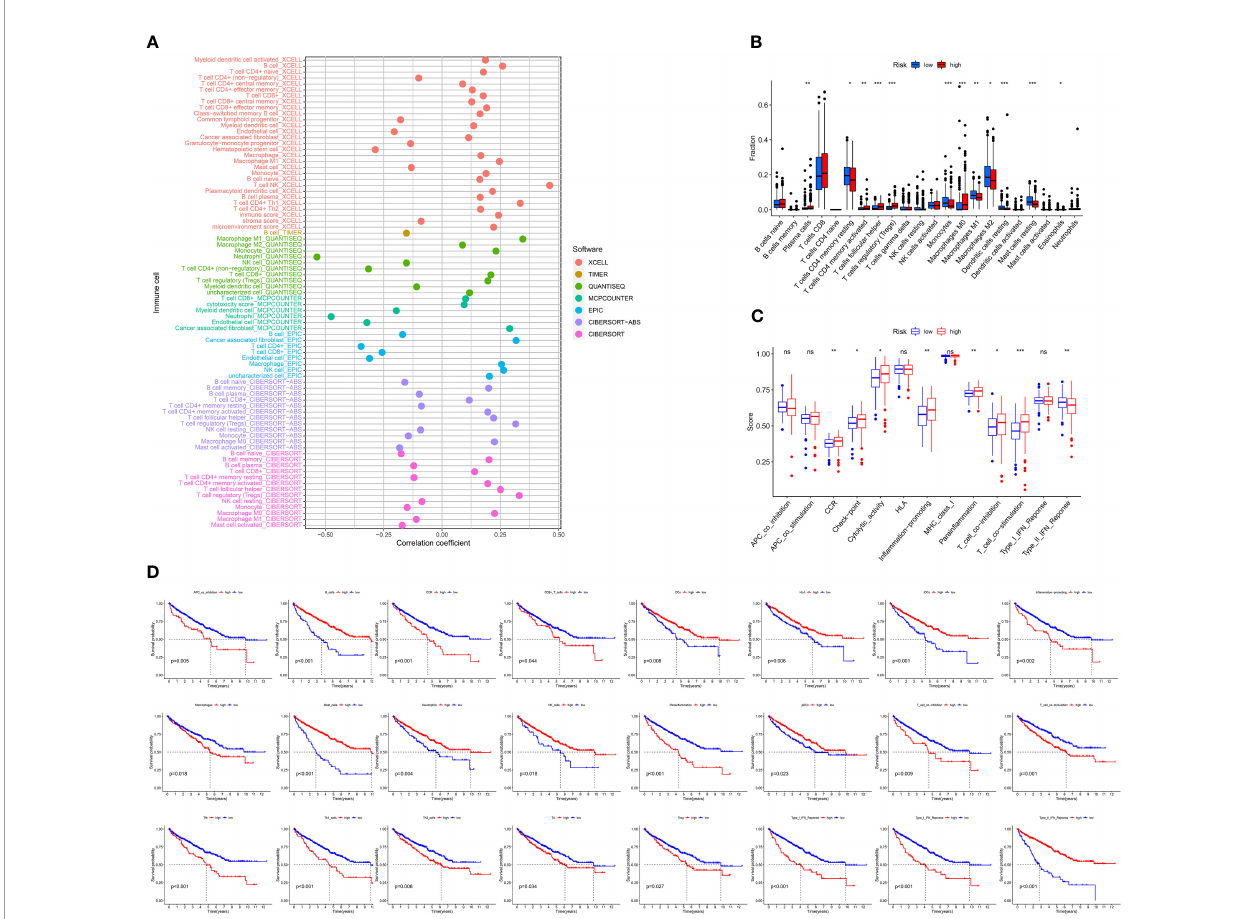
FIGURE 6 | Correlation of immune microenvironment between risk scores. (A) Correlation analysis of the risk score and immune cells by XCELL, TIMER, QUANTISEQ, MCPCOUNTER, EPIC, CIBERSORT abs, and CIBERSORT algorithm. (B) Boxplot of CIBERSORT immune cell in fi ltrate analysis in TCGA-KIRC cohort. (C) Boxplot of immune function scores between high- and low-risk groups. (D) K-M curve of immune function between high- and low-risk groups (including APC coinhibition, B cells, CCR, CD8+ T cells, DCs, HLA, iDCs, in fl ammation-promoting, macrophages, mast cells, neutrophils, NK cells, parain fl ammation, pDCs, T-cell coinhibition, T-cell costimulation, Tfh, Th1 cells, Th2 cells, TIL, Treg, type I IFN response, type I IFN response, and type II IFN